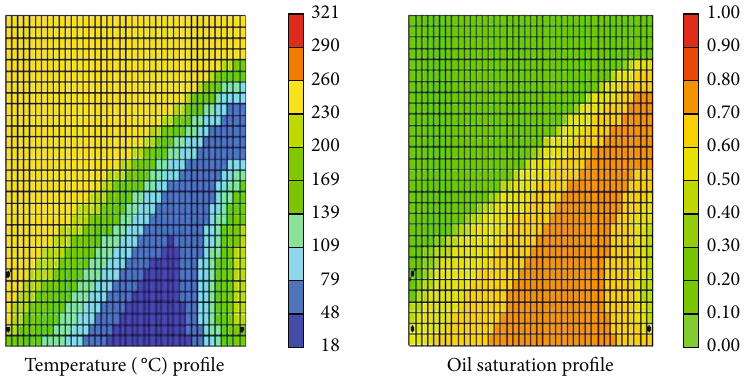
Figure 5: Temperature pro fi le and oil saturation pro fi le after the fi rst round of hu ff and pu ff for model A ( I = 1 ).